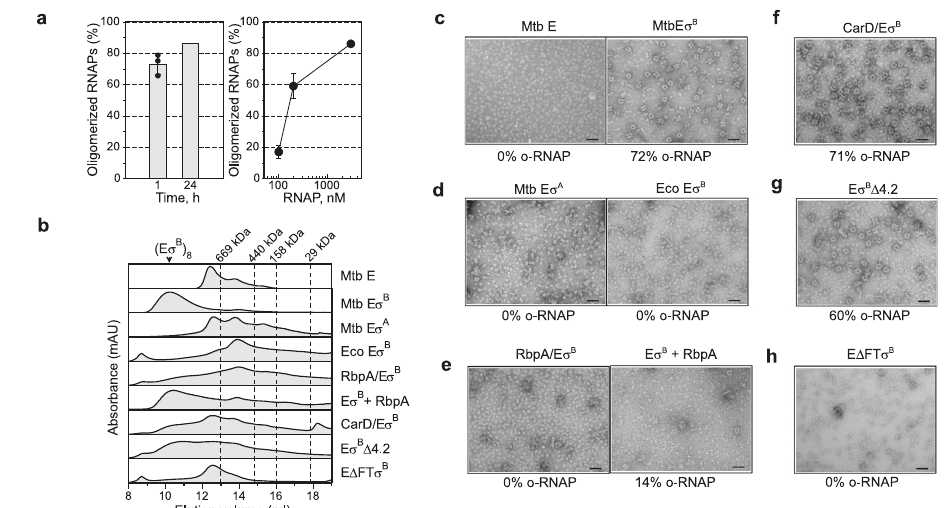
Fig. 5 | Regulation of the E σ B octamer assembly in vitro. a Time (left panel) and concentration (right panel) dependence of the E σ B octamer assembly. Bar graphs showthepercentageofRNAPmoleculesassembledinoctamersrelativetothetotal numberofRNAP moleculesvisualizedon the EM grid.Valueswerecalculatedfrom the negatively stained images by counting particles using the EMAN2 e2boxer module. When indicated, data are presented as mean values ±SD calculated from n =3 (bar graph) and n =4 (line graph) representative images. b Assessment of the RNAPoligomerizationstatebySEC.Elutionpro fi lesoftheRNAPcore(E)incomplex with a different set of transcription factors (indicated on the right) match combi- nationsshownin c – h .Theoctamerpeakisindicatedas(E σ B ) 8 .Dashedlinesindicate the position of the molecular weight markers: 669kDa, thyroglobulin;